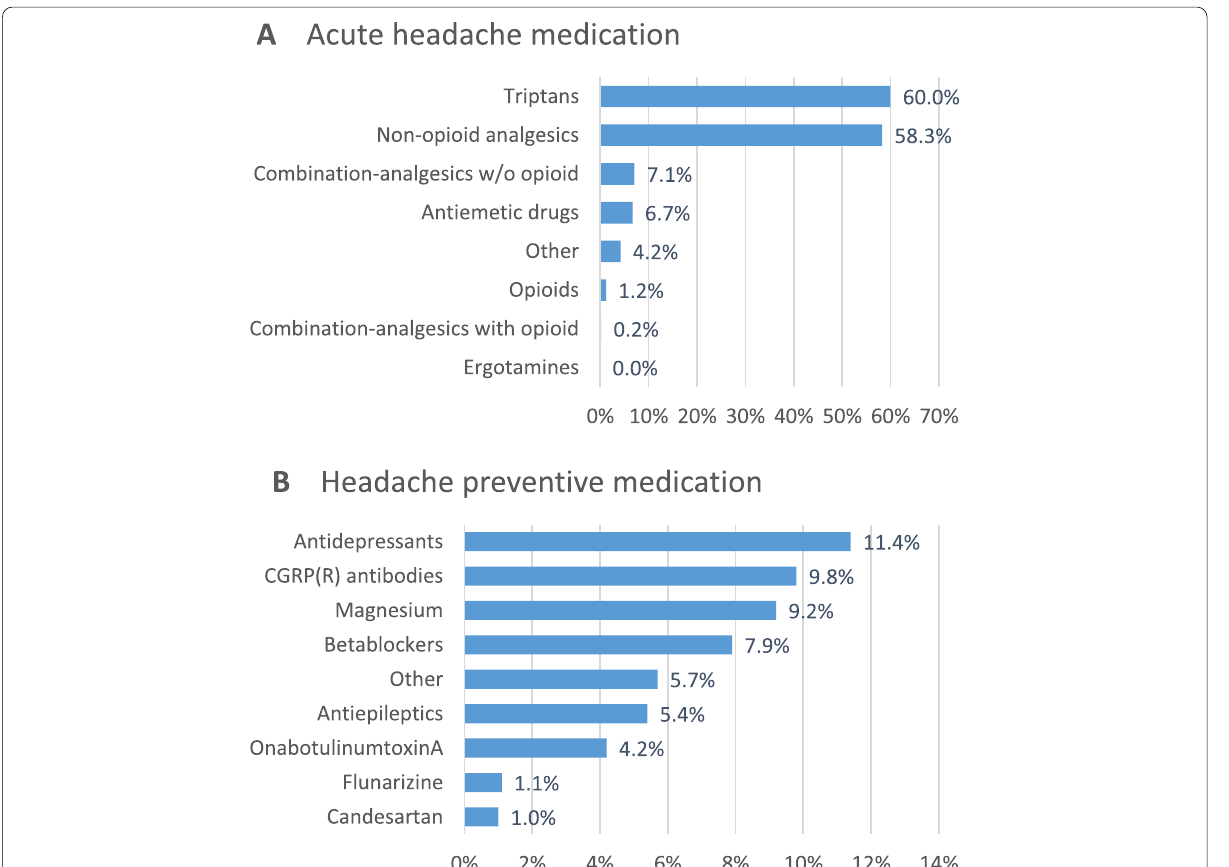
Fig. 3 Acute headache medication and headache preventive medication. 6.4% of patients did not use acute headache medication and 55% did not use headache preventive medication. Antidepressants: tricyclics and serotonin-noradrenaline reuptake inhibitors (SNRI); CGRP and CGRP receptor antibodies (CGRP(R) antibodies): erenumab, fremanezumab, galcanezumab; magnesium: including combinations with vitamin B2 and coenzyme Q10; antiepileptics: topiramate and valproate. w/o,